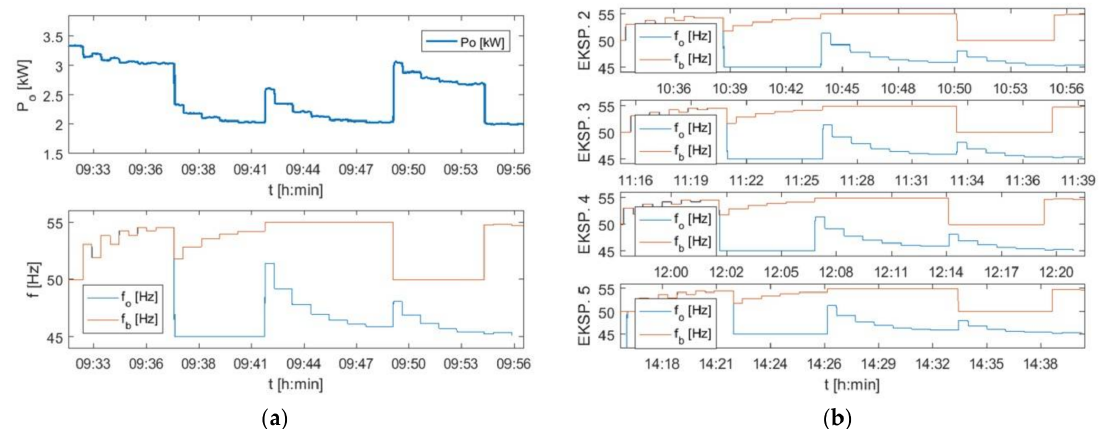
Figure 19. Exemplary results of the optimization run on installation 100 mm diameter. ( a ) without grinding media; and, ( b ) including grinding media: 100 g experiment 2, 150 g experiment 3, 200 g experiment 4 and 250 g experiment